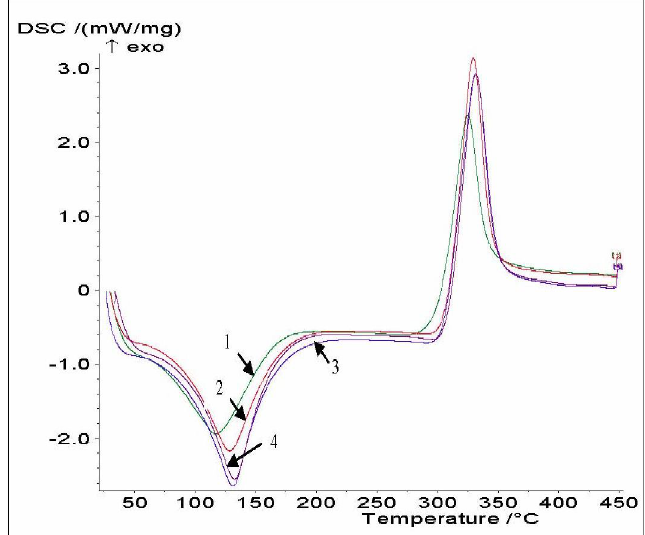
Table 5. Thermal transitions of chitosan decaetylated under different conditions (T : peak temperature; T temperature; T p